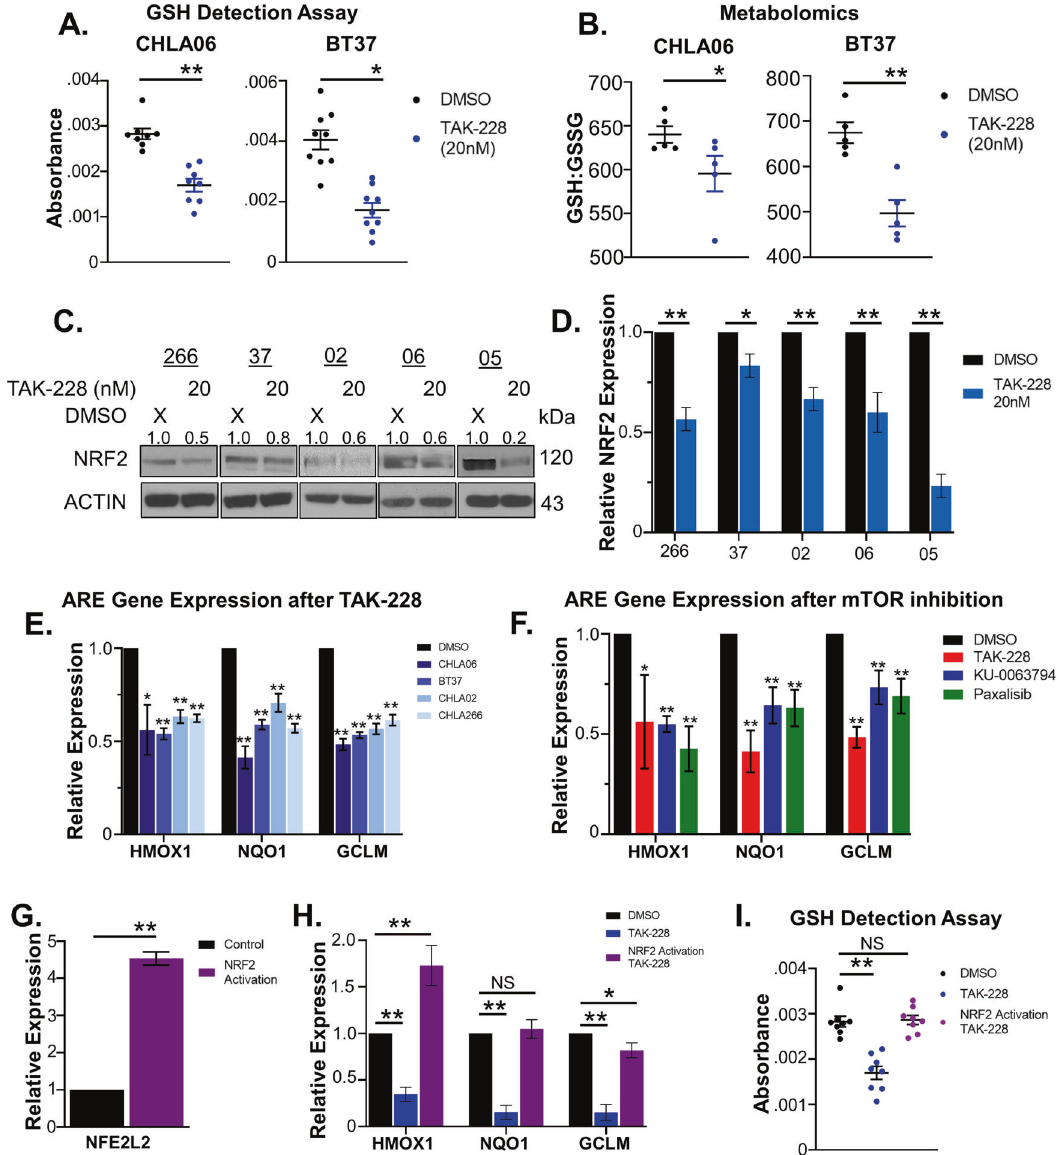
Fig. 2 TAK-228 interferes with NRF2 transcriptional activity to disrupt the oxidative stress response in AT/RT. A Intracellular reduced glutathione as determined by the glutathione-detection assay. Higher absorbance represents higher intracellular glutathione concentrations. B Ratio of reduced glutathione to oxidized glutathione as determined by metabolomics analysis. C Western blot 24 h after TAK-228 probing for NRF2 expression. Numbers above blots represent quanti fi cation of protein expression normalized to ACTIN. D Relative expression of NRF2 as determined by quanti fi cation of western blots 24 h after TAK-228 treatment. NRF2 expression is normalized to ACTIN and expressed as a ratio to DMSO control. E Relative expression of NRF2-regulated ARE genes HMOX1 , NQO1 , and GCLM 24 h after TAK-228 compared with DMSO control. F NRF2-regulated ARE gene expression 24 h after treatment with TAK-228, KU-0063794, or Paxalisib compared with DMSO in CHLA06. G Expression of the NRF2 coding gene, NFE2L2 after transduction of NRF2 lentiviral activation particles. H Expression of ARE genes after DMSO and TAK-228 treatment of empty vector control cells and after TAK-228 treatment of NRF2-activated cells. I Reduced intracellular glutathione after DMSO or TAK-228 treatment of empty vector control cells and after TAK-228 treatment of NRF2-activated cells. Results in this fi gure are presented as the mean + / − SEM, NS represents no signi fi cance, * p < 0.05, ** p < 0.005, t-